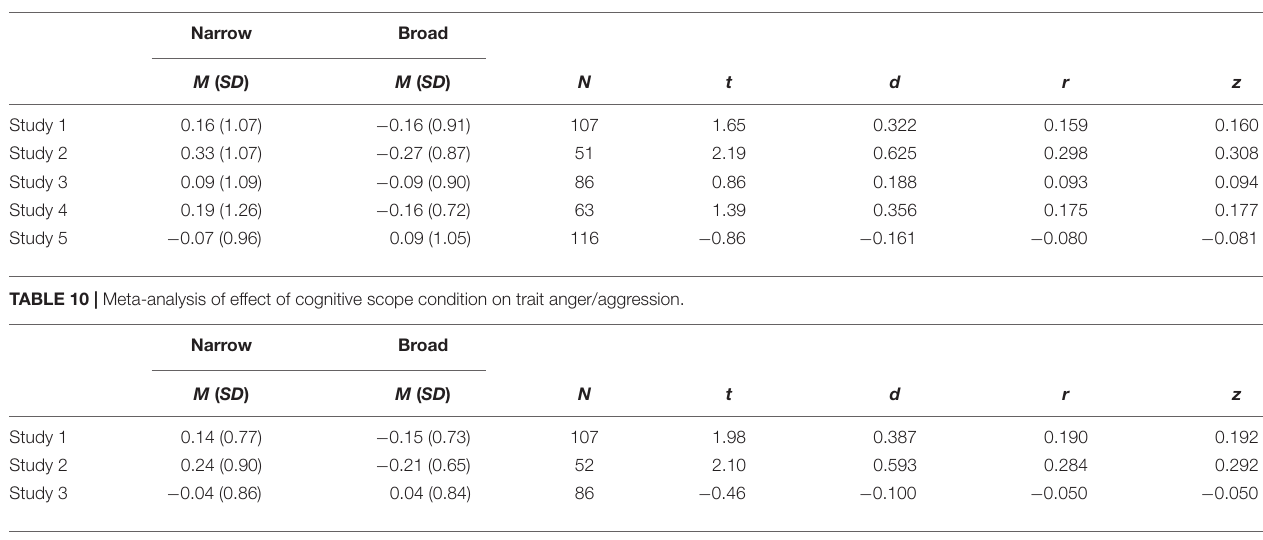
TABLE 11 | Meta-analysis of effect of cognitive scope condition on state anger/aggressive